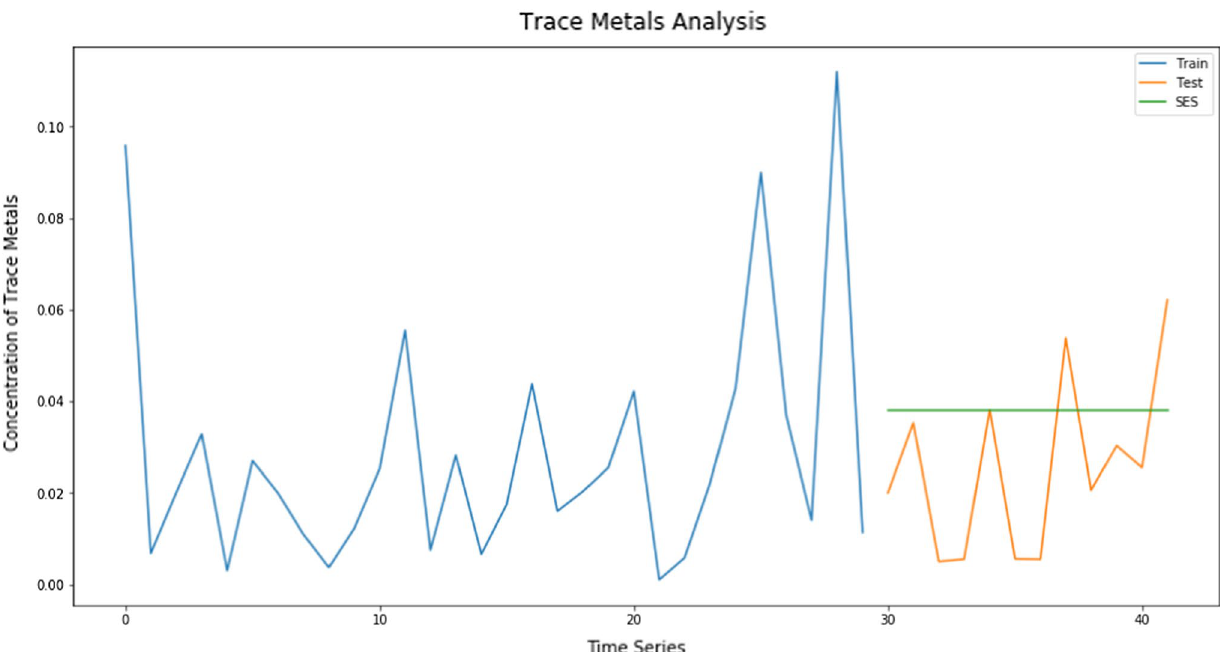
Fig. 8 Trace metals prediction using simple exponential smoothing (SES), (machine learning with Python)